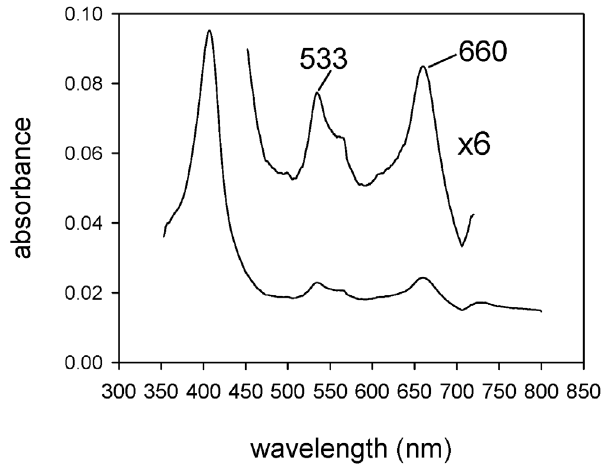
Figure 7. Spectral analysis of 10% pyridine in chloroform extract of reaction (as described in Fig. 6c) after 2 hr. Maxima at 660 and 533 nm are consistent with the accumulation of the pyridine verdohemochrome.